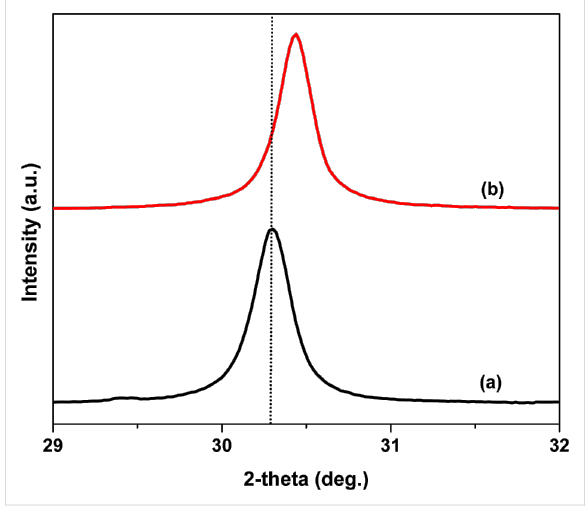
Figure 2: Expanded XRD region between 29° and 32° to show the peak shift between (a) ZrO 2 and (b) Pt(1%)-ZrO 2 .